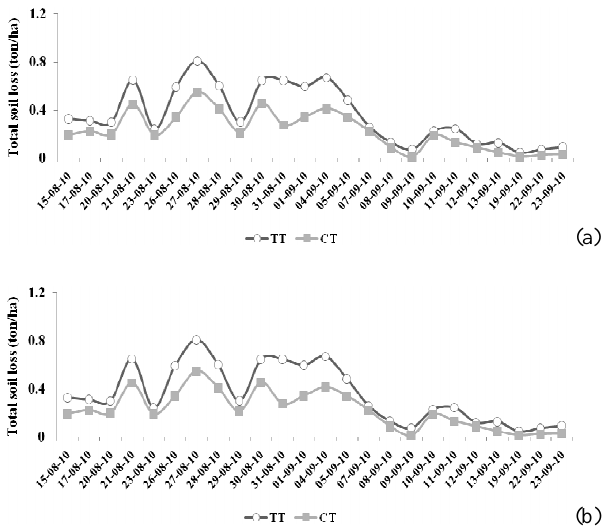
Fig. 9. Soil loss as affected by tillage treatment (a) wheat and (b) tef. Figure 9. Soil loss as affected by tillage treatment (a) wheat and (b) tef. Note the Note the higher difference in wheat than in tef as influenced by higher difference in wheat than in tef as influenced by seedbed compaction during tef seedbed compaction during tef planting and at earlier stage than planting and at earlier stage than at later due to reduced soil loss with increasing crop cover. at later due to reduced soil loss with increasing crop cover.